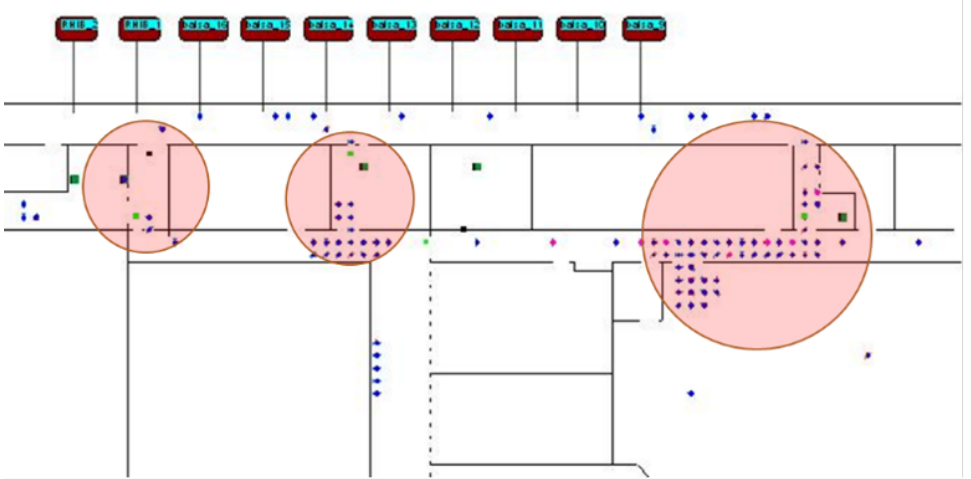
Figure 3. Unbalanced agent congestion at exits to exteriors, evacuation process (source MaritimeEX-